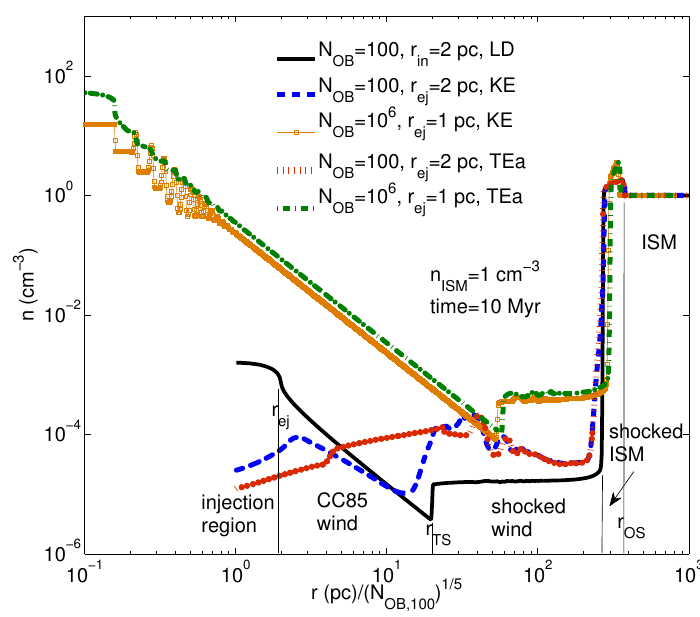
Figure 2. Density profiles vs normalized radius of the remnant formed by sequential explosions of SNe at r = 0 in a small injection sphere with r ej , see details in [48]. Energy is injected by N OB with a rate t − 1 sn = N OB / t OB , t OB = 30 Myr as assumed in [48]; energy is injected in the form of kinetic energy (KE), thermal energy (TE), or the bubble is fed by the mechanical luminosity L ej = N OB E 0 / t sn , E 0 = 1 B. It is seen that for rare explosion events each SN ejecta expands into a very low-density cavity—it is nearly an expansion into vacuum. For higher N OB the profile approach the Chevalier-Clegg wind solution [49], where every portion of energy injection has to share it with the whole bubble through thermolization. From